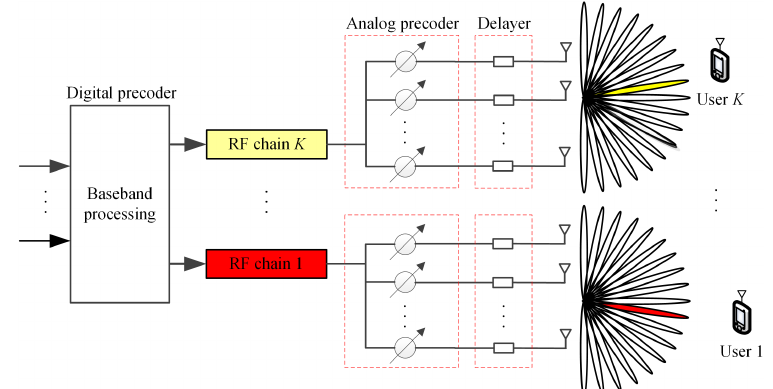
Figure 1. Broadband hybrid precoding framework based on adaptive beam